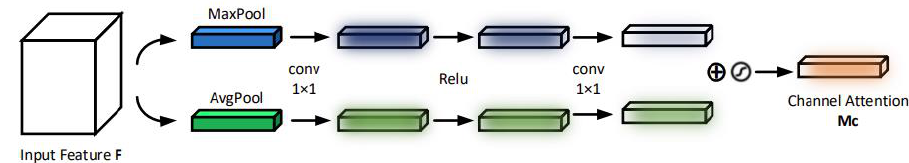
Figure 3. Network structure of the CAM.